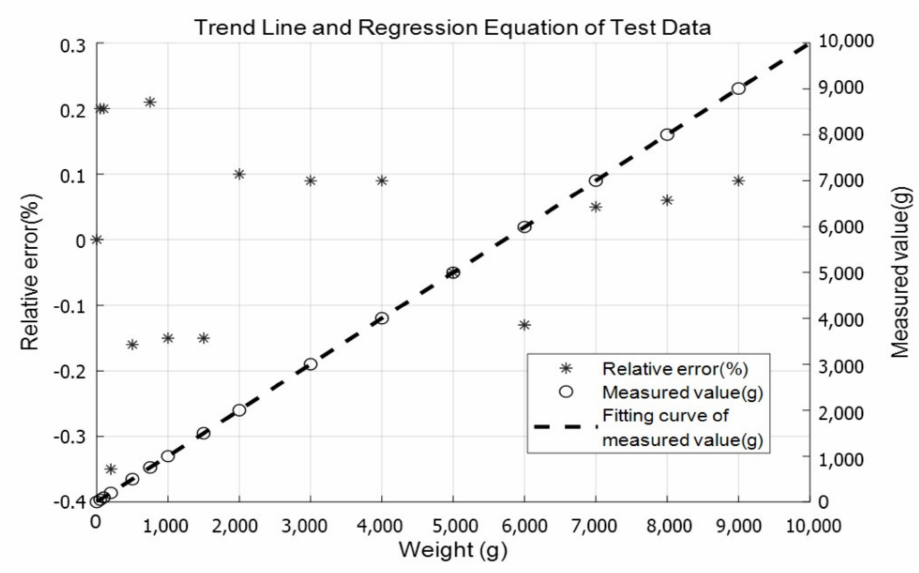
Figure 17. Trend graph of the measured value and relative error.